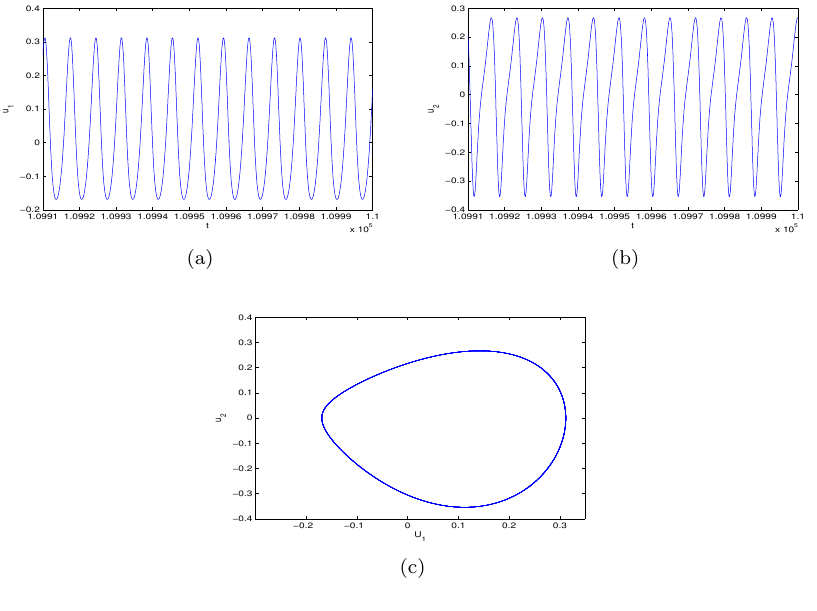
Figure 5. Simulated solution of system (4.1) for ( α 1 ,α 2 ) = ( − 0 . 001 . − 0 . 075): showing a stable periodic solution.